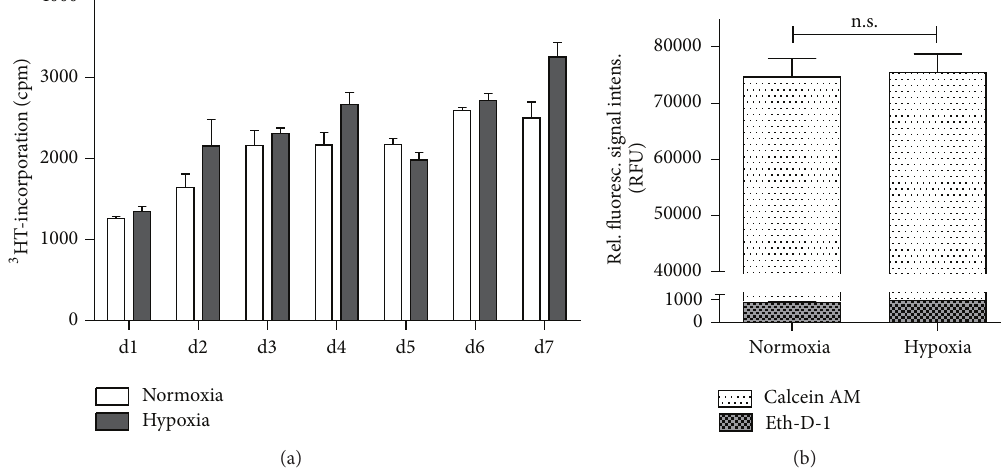
Figure 1: HeLa-hTDO cells survive incubation under hypoxic conditions. (a) Proliferation assay: 1 × 10 3 HeLa-hTDO cells were seeded per cm 2 in 25 cm 2 cell culture flask (Corning, NY, USA), 3 H-thymidine was added at day 0, and the cells were incubated under normoxia (20% O 2 ) or hypoxia (1% O 2 ) for 1–7 days. The incorporation of 3 H-thymidine was detected using liquid scintillation spectrometry (1205 Betaplate, PerkinElmer, Rodgau J¨ugesheim, Germany). (b) Fluorescence-based cell viability/cytotoxicity assays: 3×10 4 HeLa-hTDO cells per well were incubated for 24h under normoxia (20% O 2 ) or hypoxia (1% O 2 ). Then the cells were stained with Calcein AM (white bars) or Ethidium-Homodimer-1 (Eth-D-1) (plaid bars) indicating living or dead cells, respectively. After incubation the fluorescence was detected using a fluorescein optical filter (excitation 485 ± 10 nm; emission 530 ± 12 nm) for Calcein or using a rhodamine optical filter (excitation 530 ± 12 nm; emission 645 ± 12 nm) to detect Eth-D-1. For both assays a two-tailed unpaired t -test was used to compare the groups (n.s. = not significant), 𝑛 = 3 independent experiments with three replicates each. The bars indicate the mean value ± SEM.